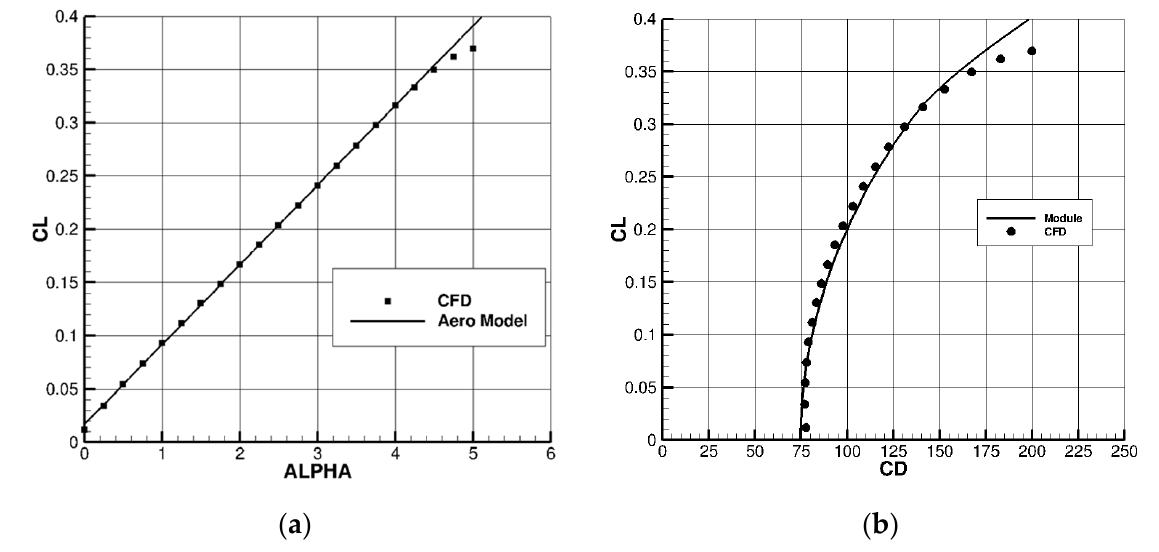
Figure 33. SMILE BWB configuration—global aerodynamic performances (M = 0.78, Alt. = 41,000 ft). Lines—aerodynamic module; symbols—CFD. ( a ) C L ( α ). ( b ) C L (C D ).